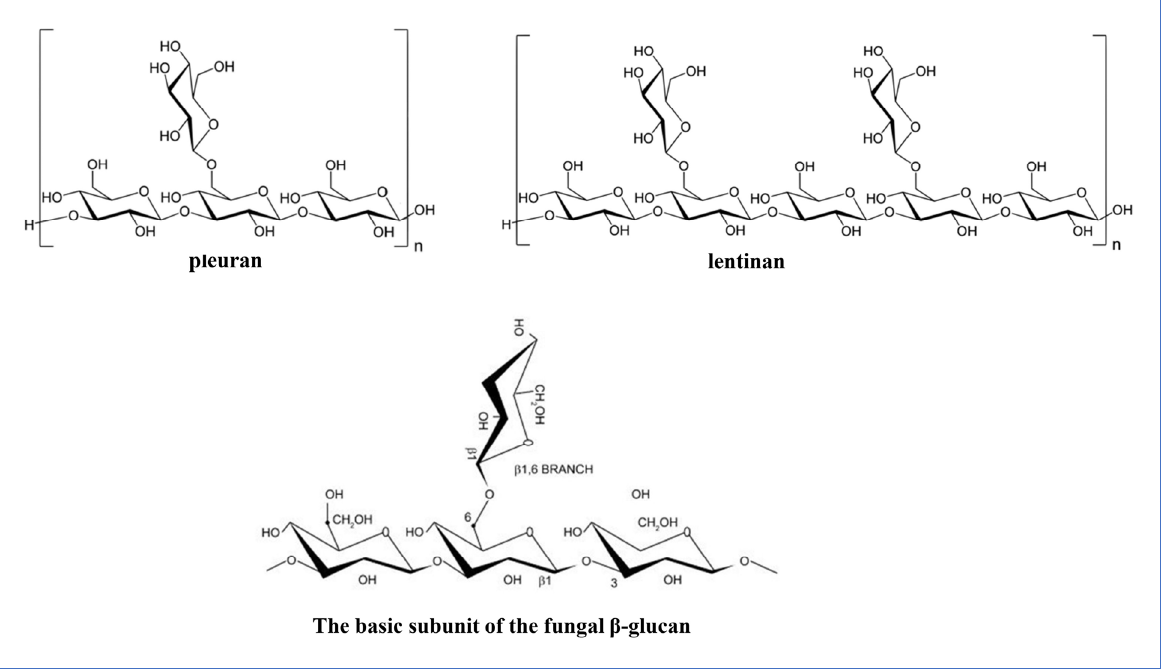
Figure 3. Chemical structure of some fungal polysaccharides.